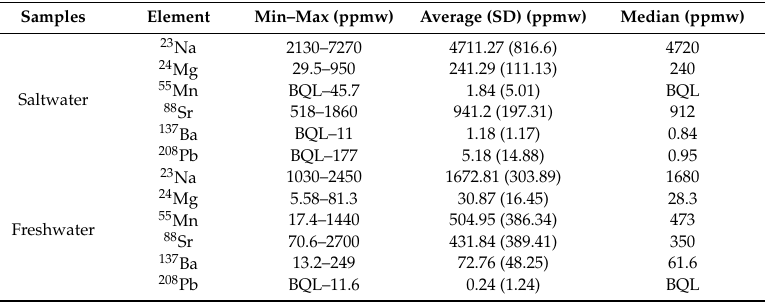
Table 3. LA-ICP-MS analysis of saltwater and freshwater samples.